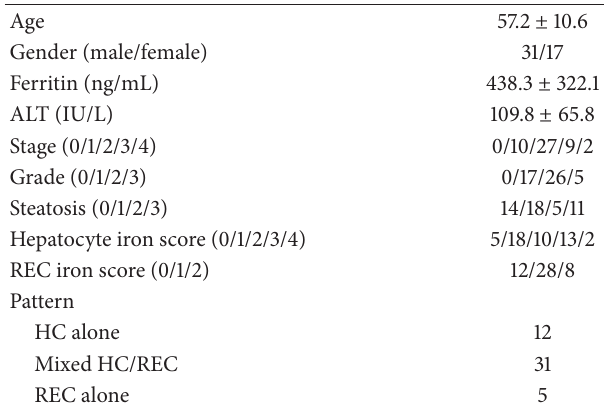
Table 3: Variables associated with sTNFR2 levels. Coefficient